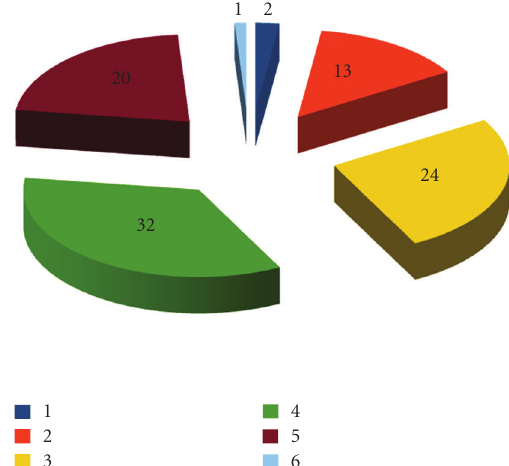
Figure 1: The distribution of optical V magnitudes of optically identified INTEGRAL gamma-ray sources. Most are brighter than mag20, and more than half are brighter than mag 15. Legend dark blue = mag 2–6, orange = mag5–10, yellow = mag 10–14, green = mag 14–18, purple = mag 18–22, light blue = mag22–26. The numbers in the plot indicate number of objects with optical V magnitude within the indicated